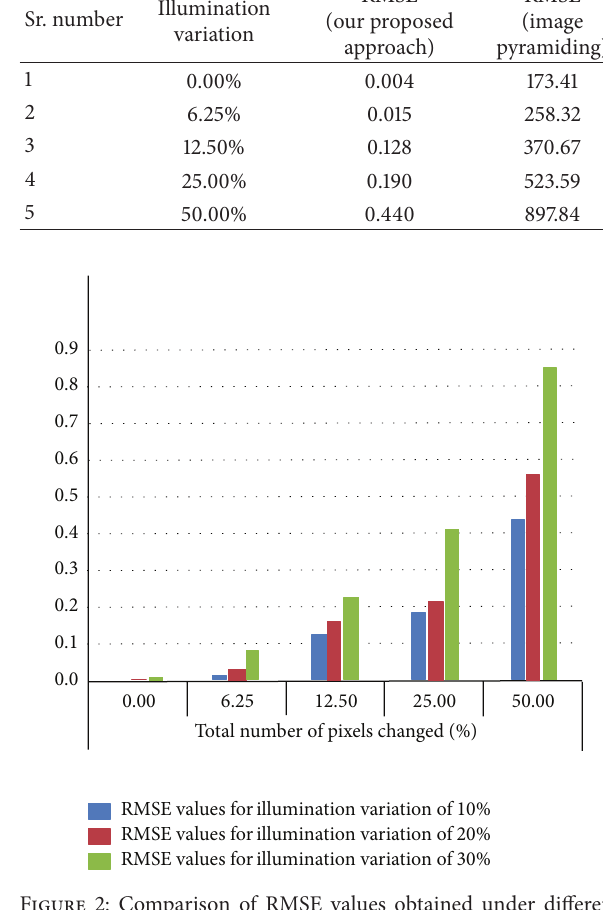
Figure 2: Comparison of RMSE values obtained under different illumination variation with different percentage of pixels within image changed (input stereo pair: